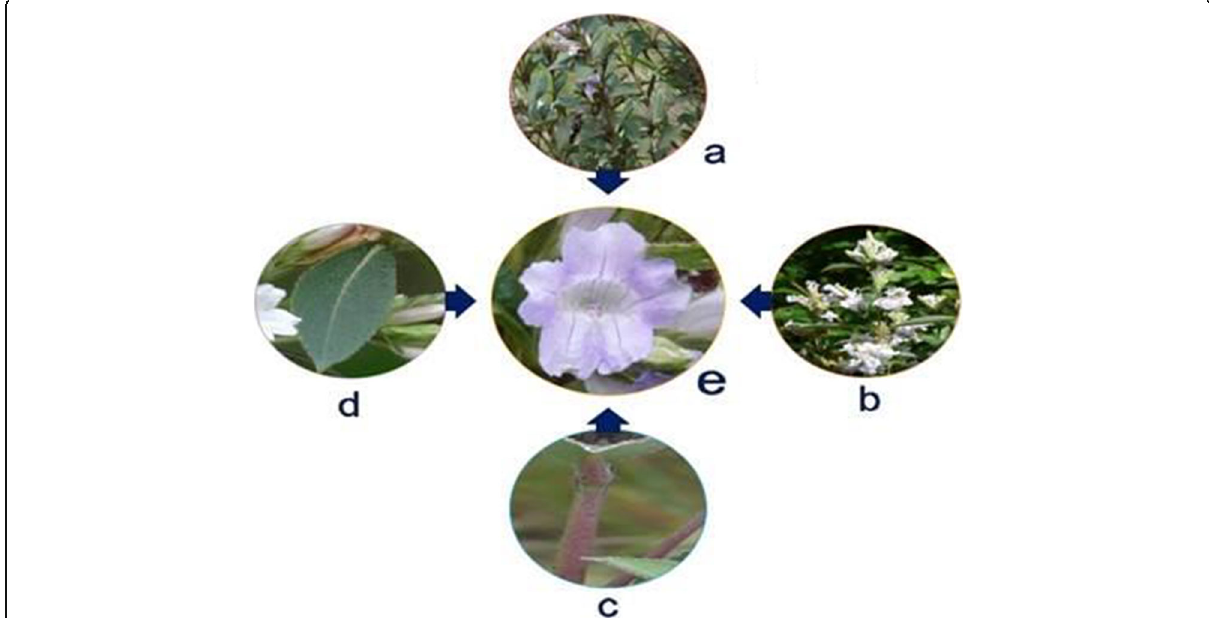
Fig. 2 Salient botanical features of Neelakurinji (Strobilanthes wightiana). a Full-grown bushy shrub, b flower-bearing shrub, c stems with glabrous to sparsely pubescent barks, d elliptic-ovate with stout hairs with subentire to prominently serrated leaves, e pale blue or pale lilac or mauve flower (Photographs are not in scale) (Source: unpublished photographs of Ravi Kiran